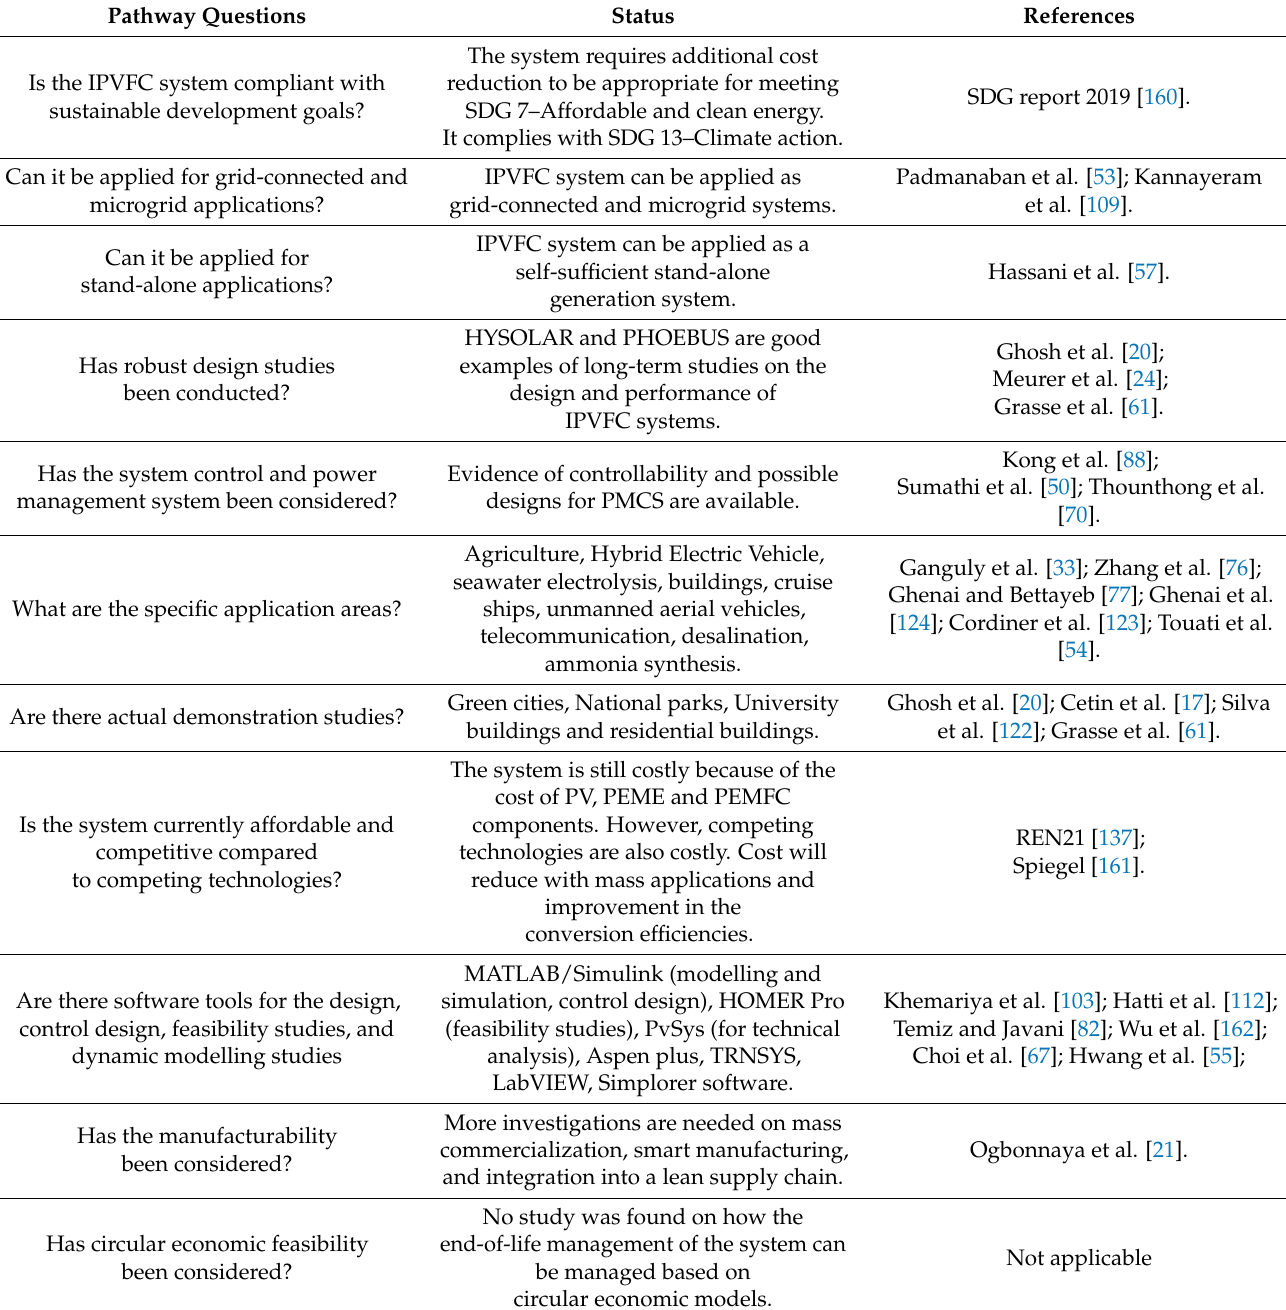
Table 5. Assessment of critical aspects towards the full commercialisation of IPVFC